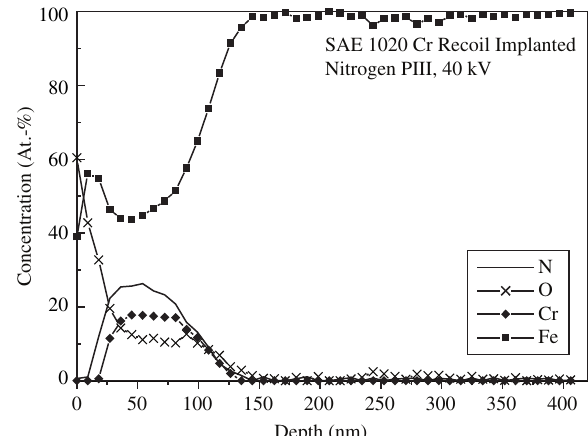
Figure 4. AES depth profile of the Cr into SAE 1020 matrix, after N PIII bombardment at 40 kV.